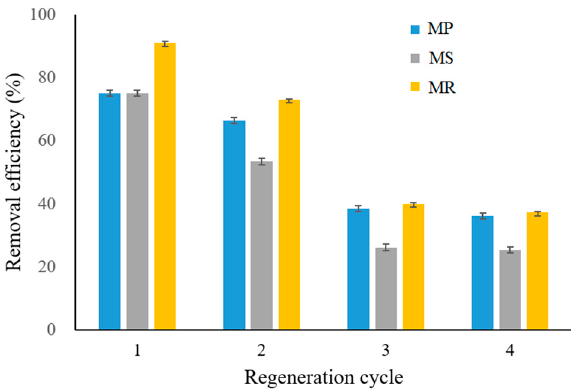
Figure 7. Reusability capacity for MP, MS, and